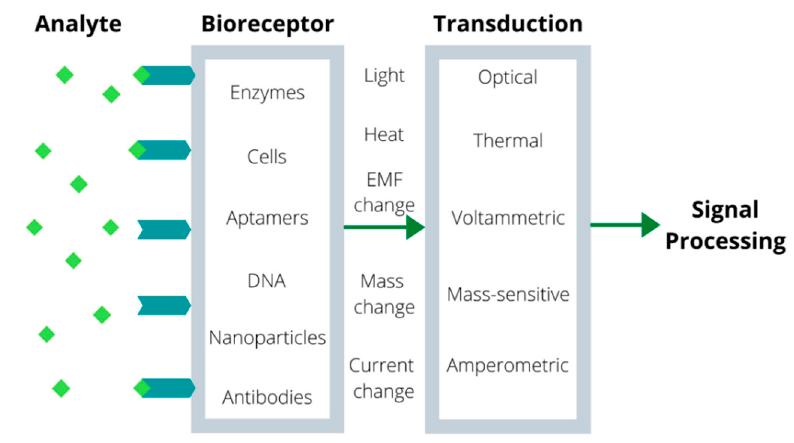
Figure 1. Schematic representation of a biosensor.